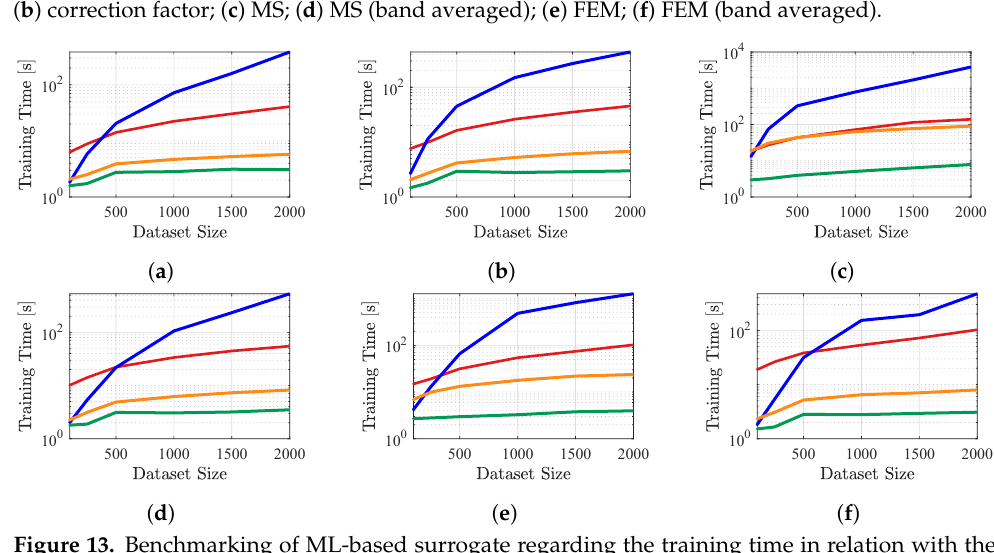
Figure 13. Benchmarking of ML-based surrogate regarding the training time in relation with the dataset size: neural network; Gaussian process regressor; random forest; gradient boosting trees; ( a ) infinite plate; ( b ) correction factor; ( c ) MS. ( d ) MS (band averaged); ( e ) FEM; ( f ) FEM (band